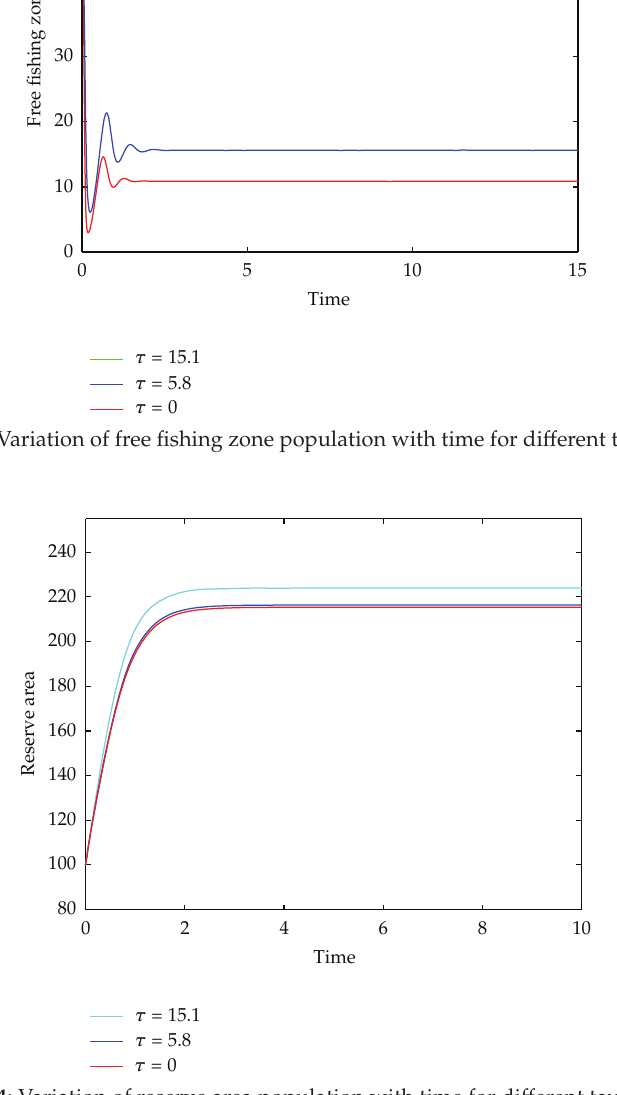
Figure 4: Variation of reserve area population with time for di ff erent tax